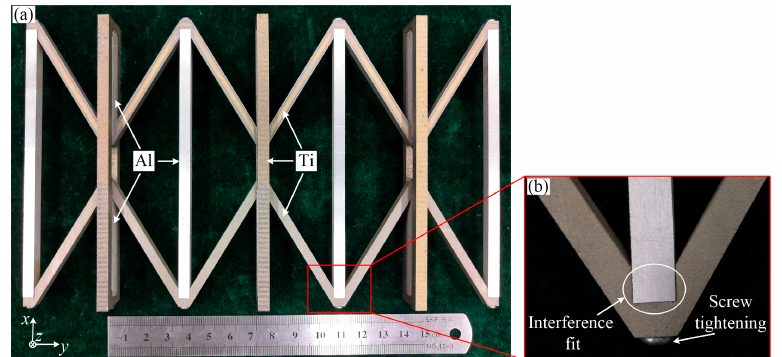
Figure 8. Images of the ITL sample. ( a ) Top view of the ITL lattice made of titanium (Ti TA2) and aluminium alloy (Al 7075-T6); ( b ) photograph of the joint. It uses an interference fit and fastens with screws.